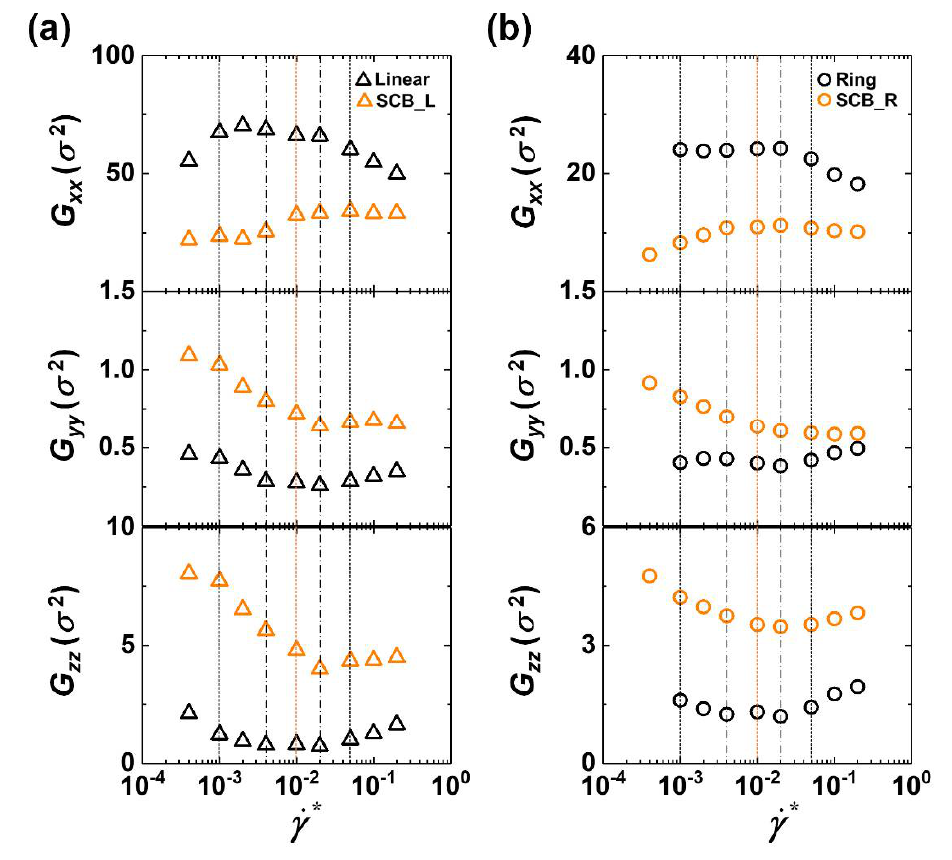
N (cid:80) N 1 − r − r ( r )( r ) ,    G r r r r = , c , α N c , β i , α i , β      i, c, i, c, N i = 1  i 1